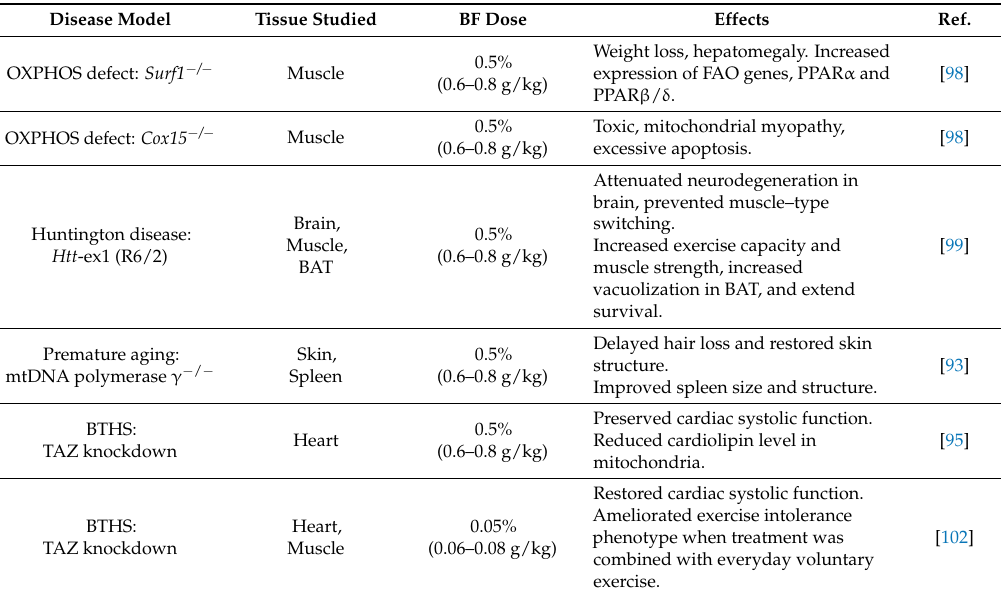
Table 1. Bezafibrate trials using mouse genetic models with mitochondrial defects. Disease Model Tissue